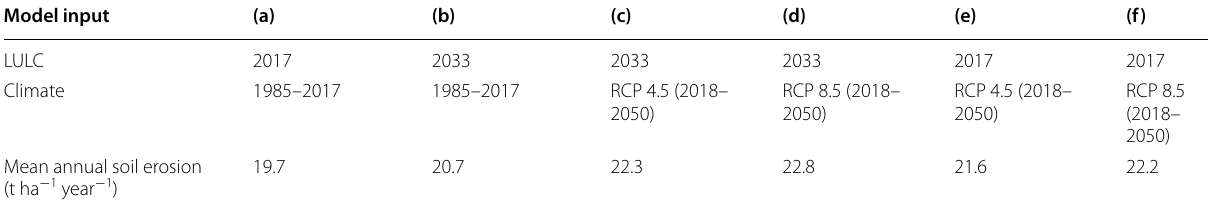
(a) Baseline period (land use/land cover in 2017 and baseline climate), (b) impacts of land use/land cover change, (c) combined impacts of future land use/land cover (2033) and climate change under RCP4.5, (d) combined impacts of future land useland cover and climate change under RCP8.5, (e) only impacts of future climate change under RCP4.5, (f) only impacts of climate change under